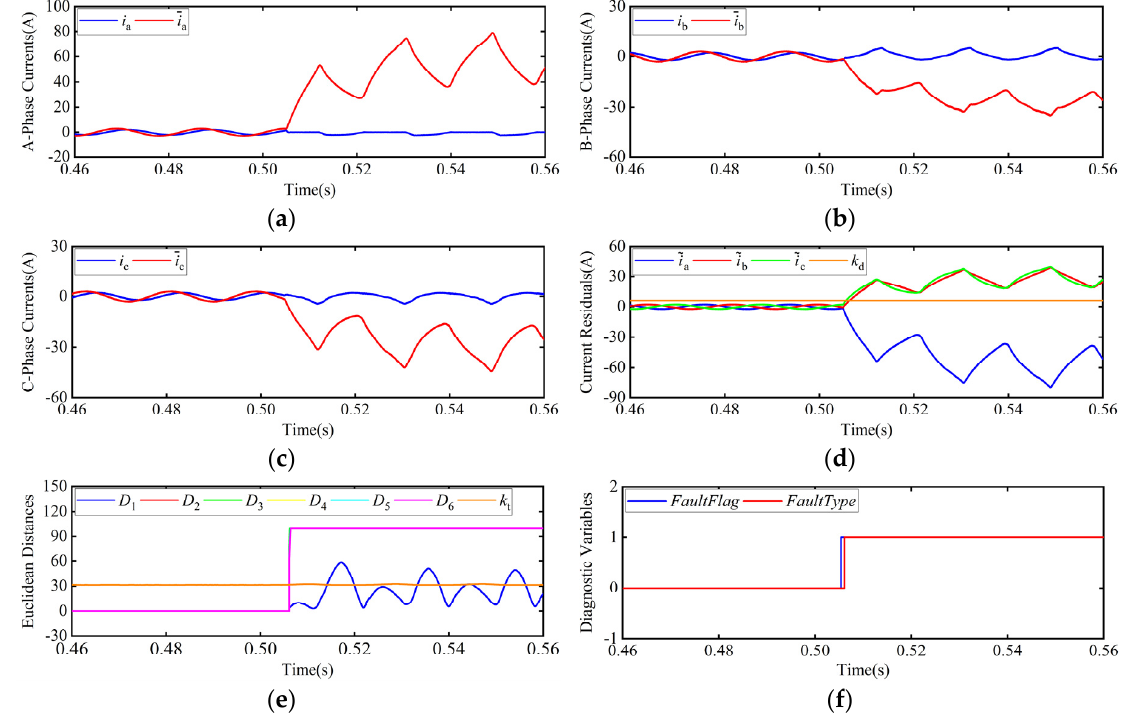
Figure 10. Diagnostic results of 20% parameter deviations: ( a ) A-phase currents; ( b ) B-phase currents; ( c ) C-phase currents; ( d ) current residuals; ( e ) Euclidean distances; ( f ) diagnostic variables.